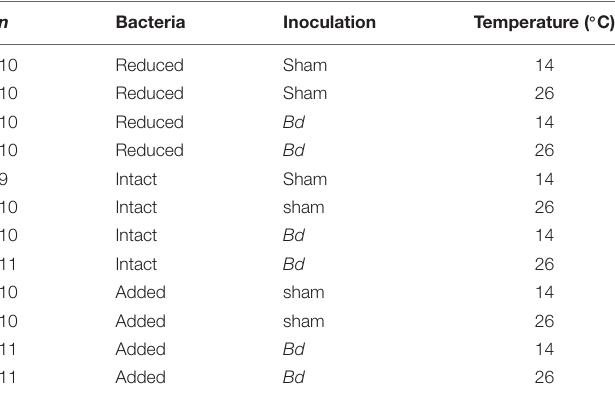
TABLE 1 | Treatment groups.